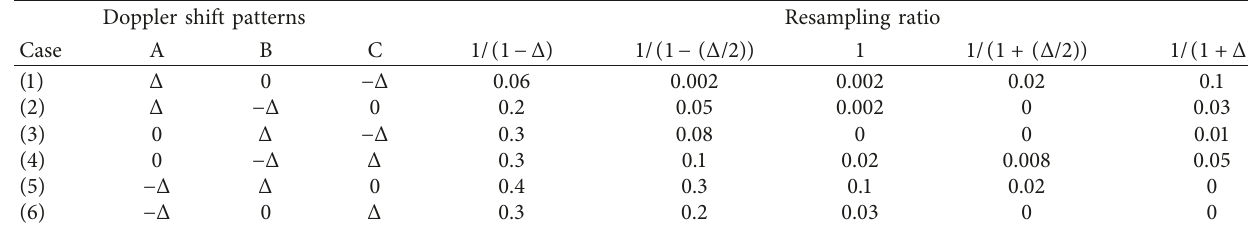
Table 3: BER results Doppler shift patterns and resampling